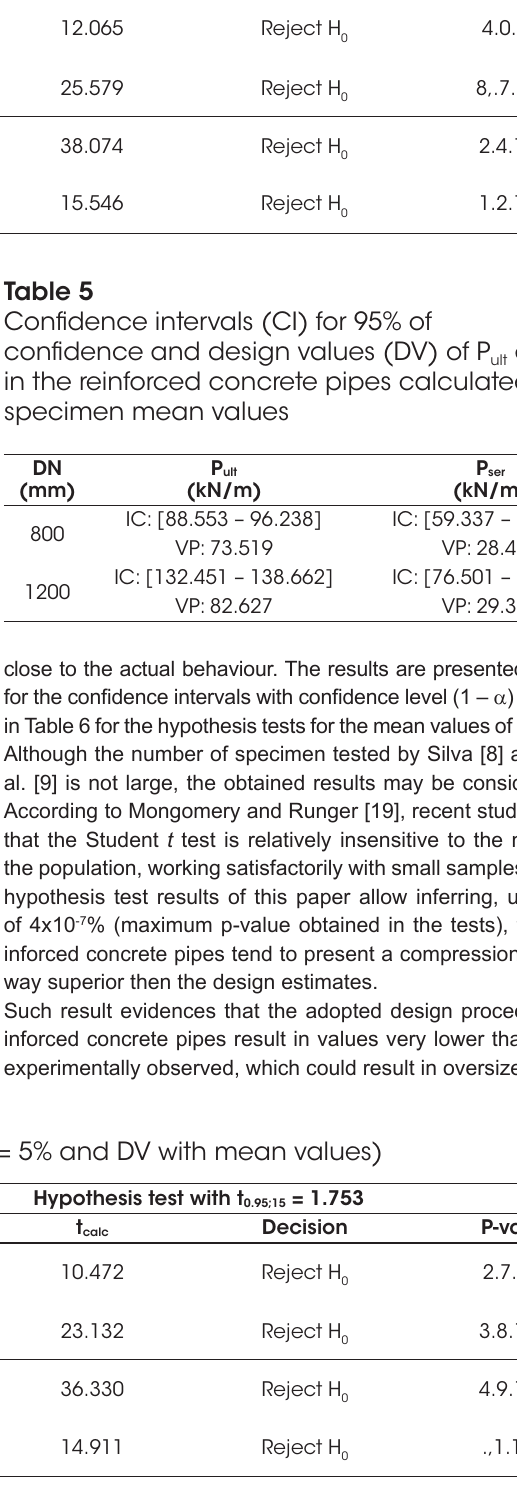
Hypothesis test for the mean values of P DN (mm)